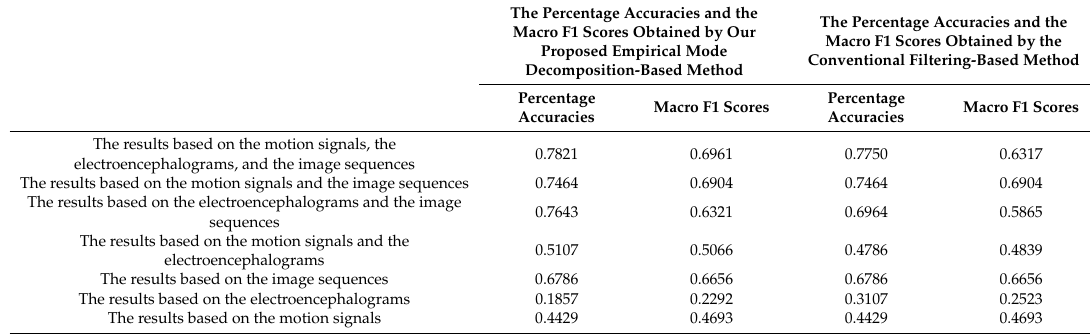
The Percentage Accuracies and the Macro F1 Scores Obtained by Our Proposed Empirical Mode Decomposition-Based Method